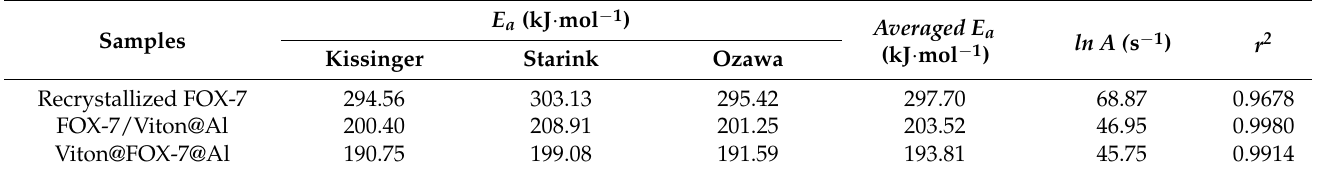
Figure 7. DSC patterns of ( a ) recrystallized FOX-7, ( b ) FOX-7/Viton@Al and ( c ) Viton@FOX-7@Al under the heating rates of 5, 10, 15 and 20 °C·min − 1 .